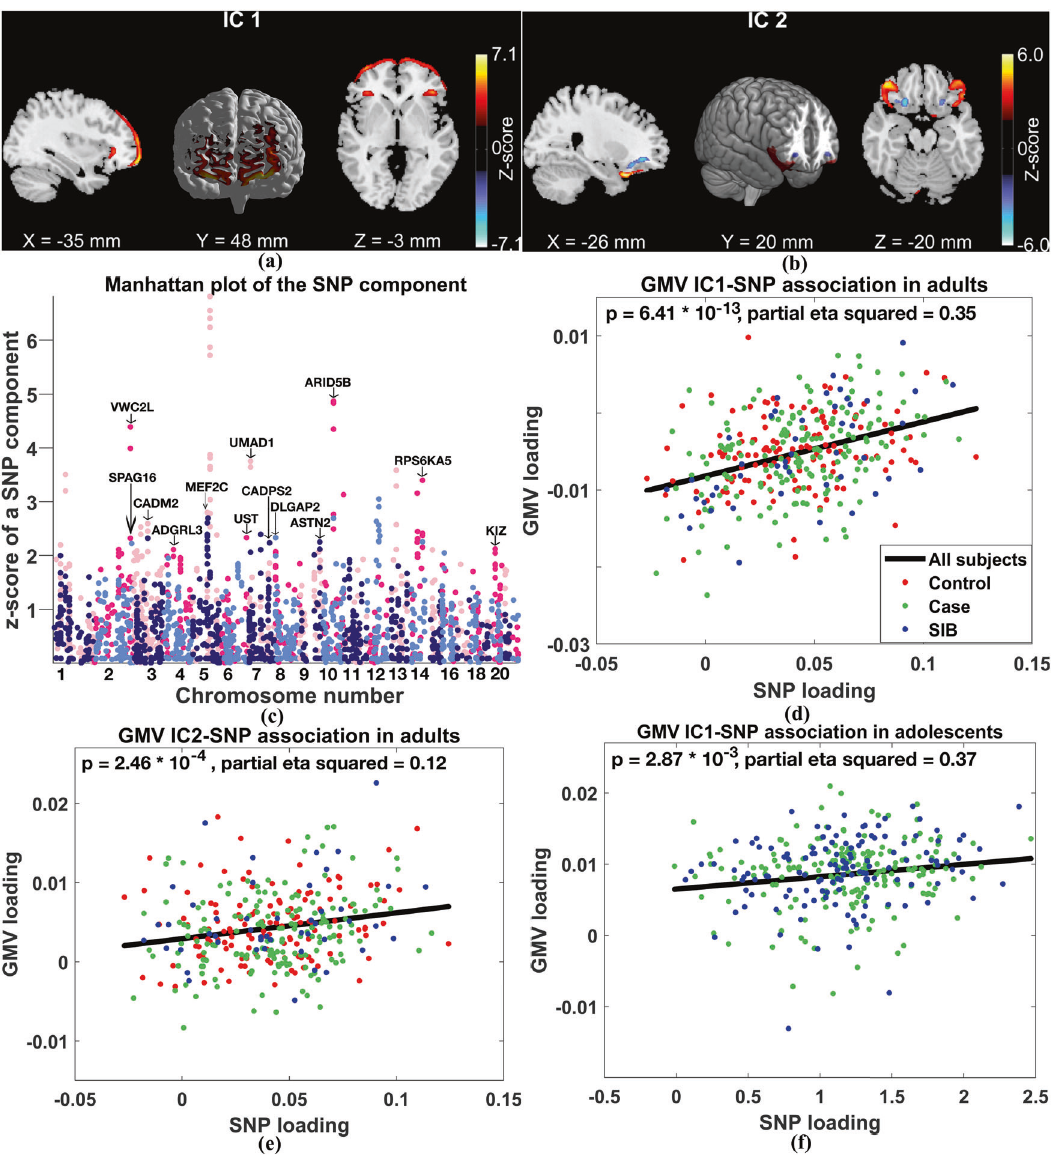
Fig. 2 Results of spICA in discovery and replication sets. The identi fi ed ( a ) GMV IC 1, ( b ) GMV IC 2, and ( c ) SNP component. The association between GMV IC 1 and SNP component was ( d ) signi fi cant in adults (the discovery set) and ( f ) replicated in adolescents (the replication set). e The association between GMV IC 2 and SNP component was signi fi cant in adults. In subplots a – c , hot colors represent positive weights, and cold colors denote negative weights. In subplots d – f , black, red, green, and blue colors represent all subjects, controls, cases, and unaffected siblings